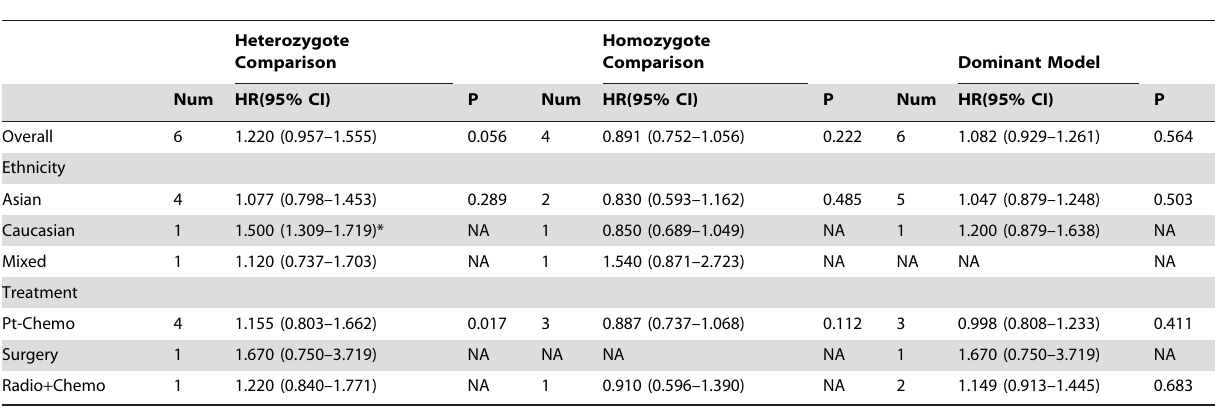
Table 3. The association of XRCC3 Thr241Met polymorphism and survival of